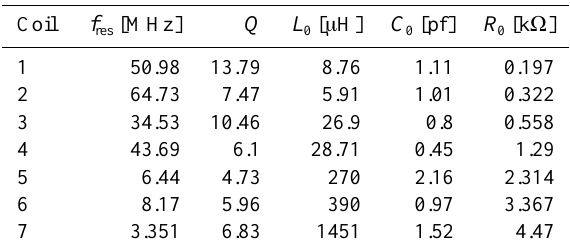
Figure 5. Relative Quality factor error ∆ Q / Q for both cases of res- onance frequency. Case 1: Re ( Z ) maximum; Case 2: Im ( Z ) mini- mum. Table 3. Measured and computed parameters of di ff erent multilayer micro